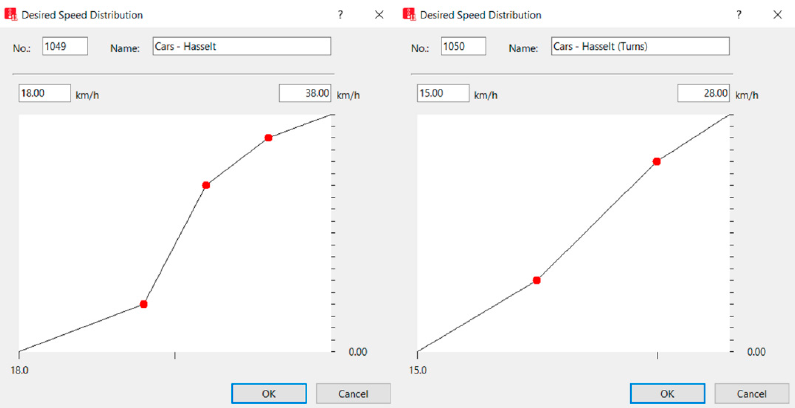
Figure 8. Implemented speed distributions for automated vehicles (AVs) for normal routes ( left ) and turns ( right ).